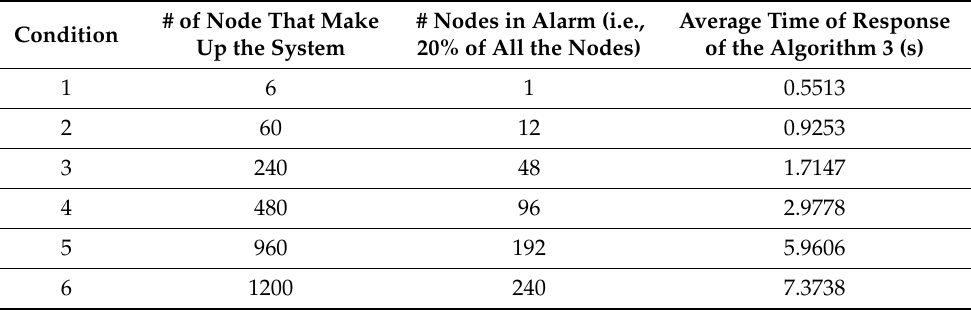
Table 6. Results of the scalability